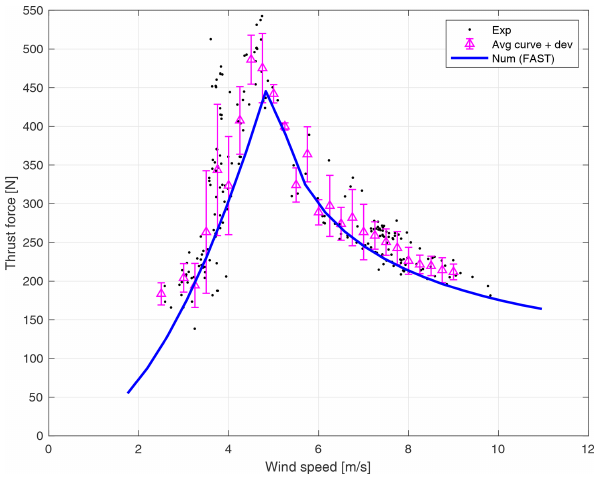
Figure 12. Comparison between target and experimental thrust curve evaluated from blade